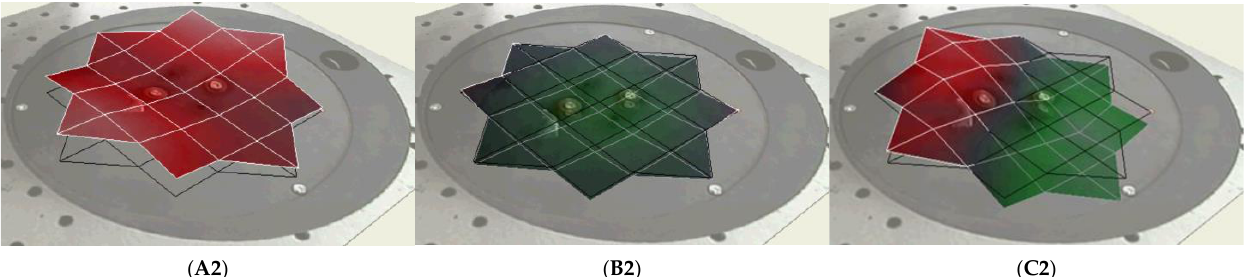
Figure 8. Comparison of simulation results and test results. ( A1 ) f 1 = 629.15 Hz. ( B1 ) f 2 = 1131.9 Hz.